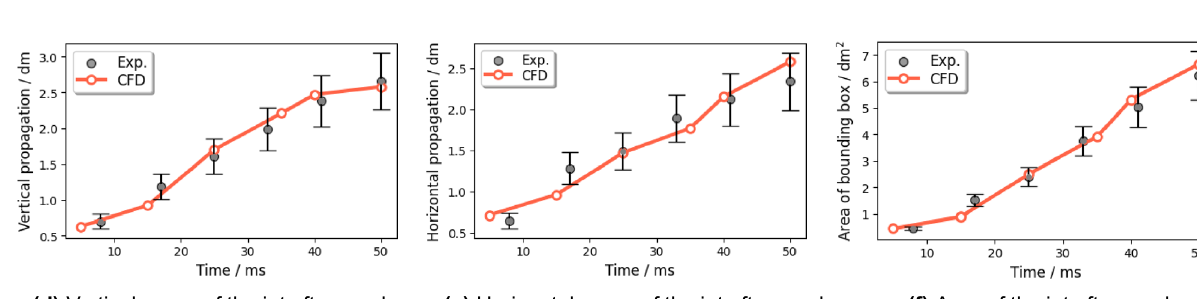
Figure 18. The comparison of cough propagation range between the CFD result of Cases 1 (normal cough)/ Case 2 (cough with gauze mask) and Schlieren experimental